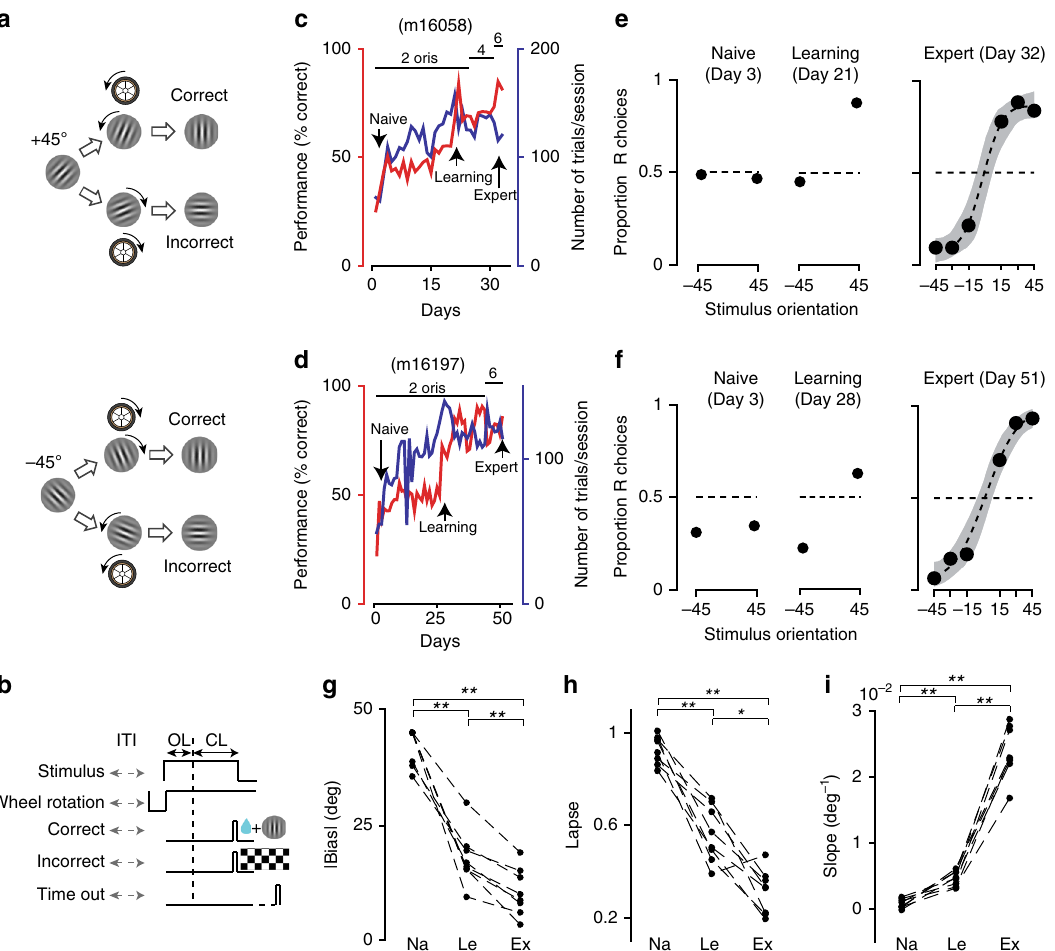
Fig. 3 Two-alternative forced choice visual discrimination task. a Example trial: a sinusoidal static grating with +45° clockwise (top) or − 45° counterclockwise (cc, bottom) orientation from vertical was presented on the screen. Mice had to indicate whether the orientation was clockwise or cc by rotating with the front paws a wheel position between them and the screen, with the wheel rotation controlling the real-time close-looped orientation of the visual stimulus. b Trial structure of reward and negative feedback; ITI inter trial interval (randomized), OL open-loop period, CL close-loop period. c Changes in performance and number of trials over training days for an example mouse (m16058), colors re fl ect the left – right y -axes. Top horizontal bars and numbers indicate changes in the number of orientations the animal had to discriminate: two orientations ( ± 45, a ), up to six orientations for a minimum deviation from vertical of ± 15°. The number of orientations increased when performance reached ~70%. d Same as c for a different example mouse (m16197). e , f Psychometric curves during three different learning phases, naive, initial learning, expert, for m16058 ( e ) and m16197 ( f ). Shaded area in the expert curves represent 95% bootstrapped con fi dence interval. g – i Changes in bias, lapsing rate, and slope derived from psychometric functions (and from a linear model for two orientation conditions, Methods) during learning ( n = 8 mice). Each dot is an average across the fi rst 6 days of the corresponding learning phase (Na, Le, and Ex for naive, learning, and expert). P -values are calculated from two-tailed Wilcoxon signed rank tests, ** P < 0.01, * P <